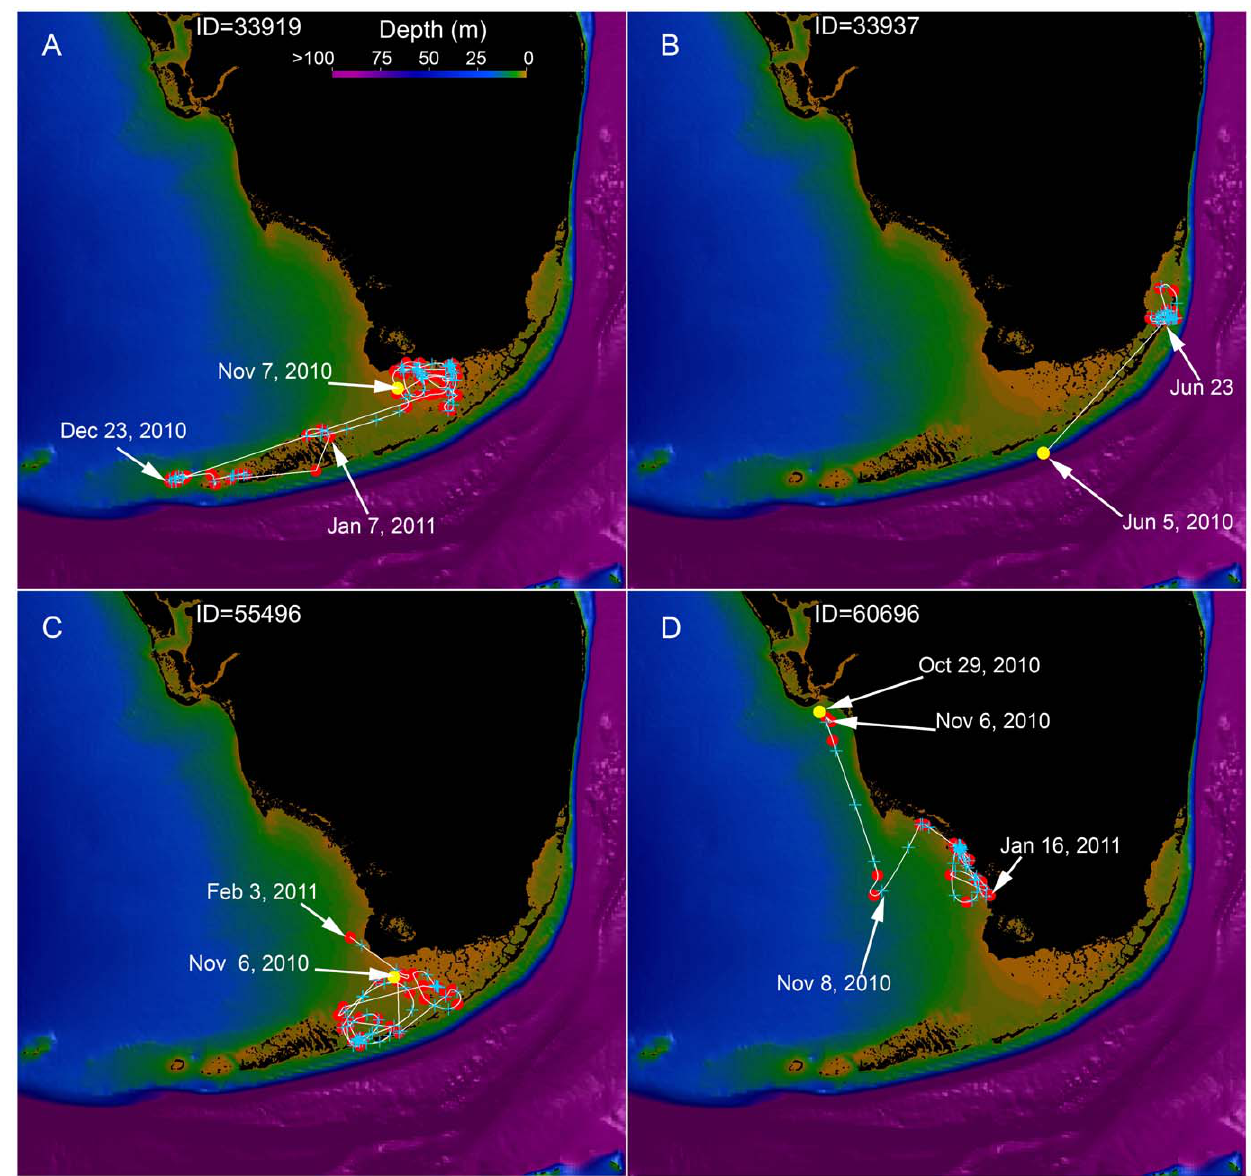
Figure 3. Representative example of four different bull shark tracks overlain on regional bathymetry. Red dots indicate the Argos locations, the white line is the 1-minute Bezier interpolated track, and the blue plus symbols are the 12-hour positions. The yellow dot is the tagging location. The depth is scaled from 0 to 100 m as indicated by the color bar. Major geographic locations are labeled in Fig. 1.